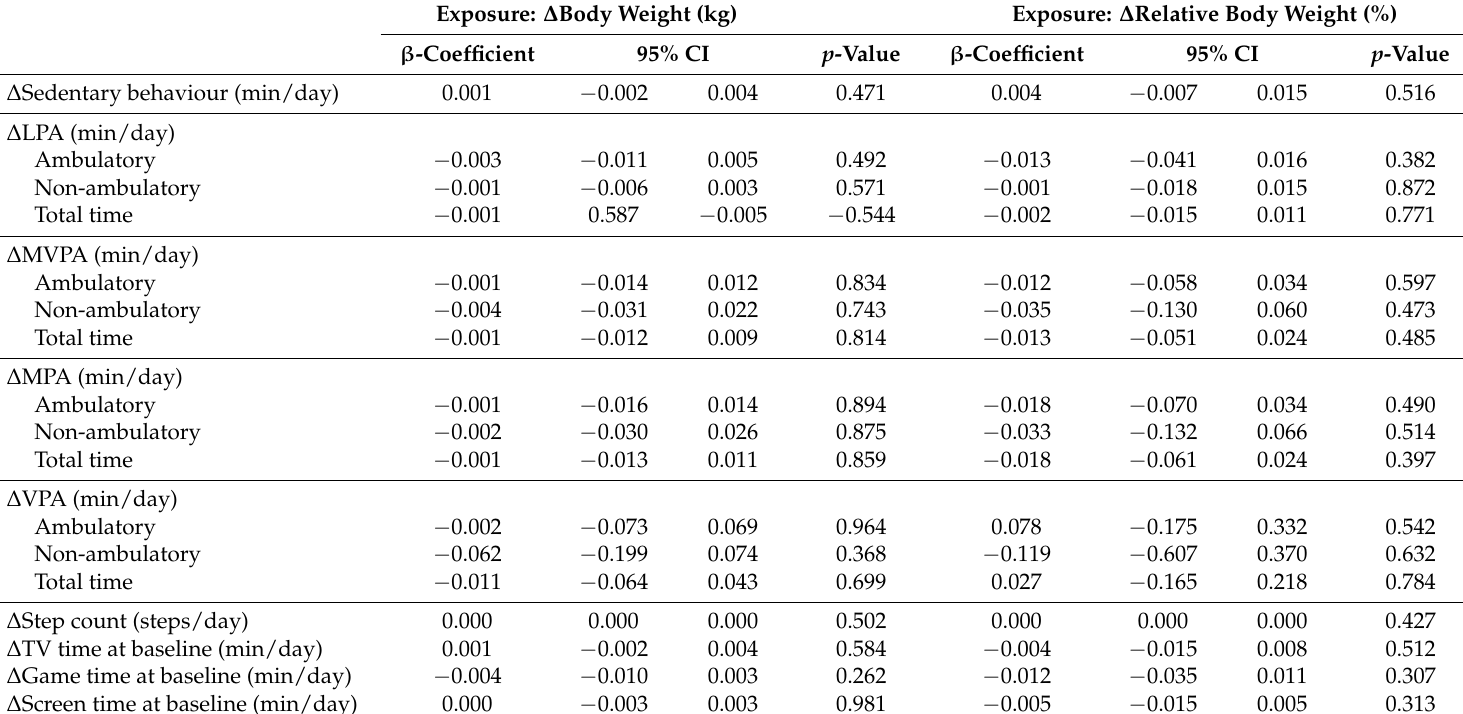
Table 3. Associations between change on body weight or relative weight and change on sedentary behaviour or physical